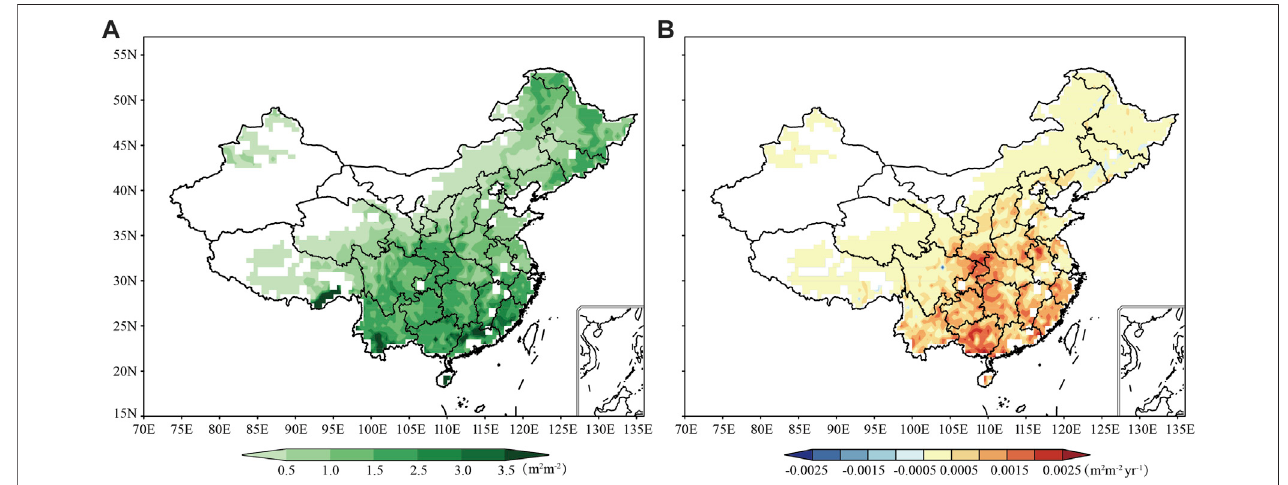
FIGURE2| Spatialdistribution ofthe (A) annualmeanLAI,and (B) Theil – SenslopetrendsofLAIduring1982 – 2015.Theshadesindicatethetrendpassingthe5% signi fi cance